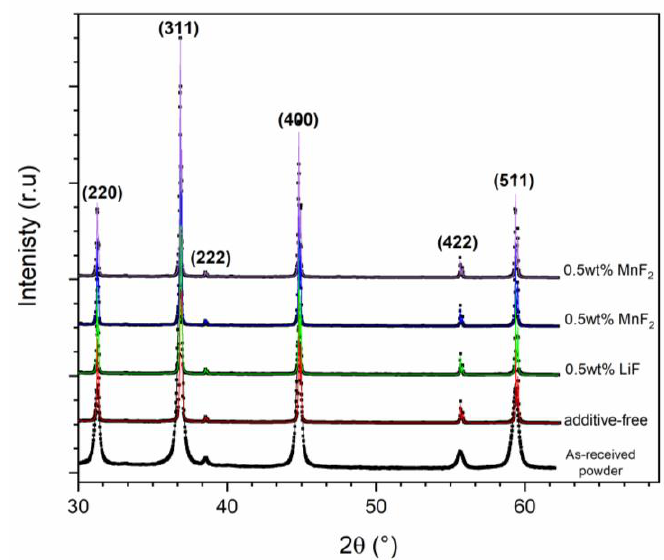
Figure 4. XRD patterns of additive-free and doped samples with 0.5 wt% (LiF, MnF 2 , and CoF 2 ), spark plasma sintered at 1400 °C. The diffraction pattern of additive-free powder is also shown for comparison. The experimental data are fitted by the model patterns obtained by Rietveld refinement of experimental data.